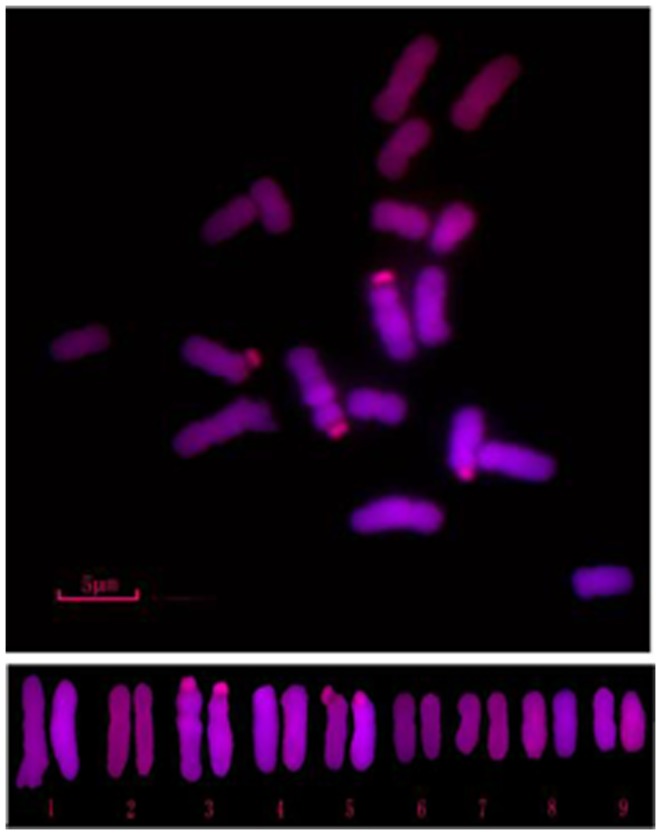
The number of chromosomes and karyotype of H. cordata.